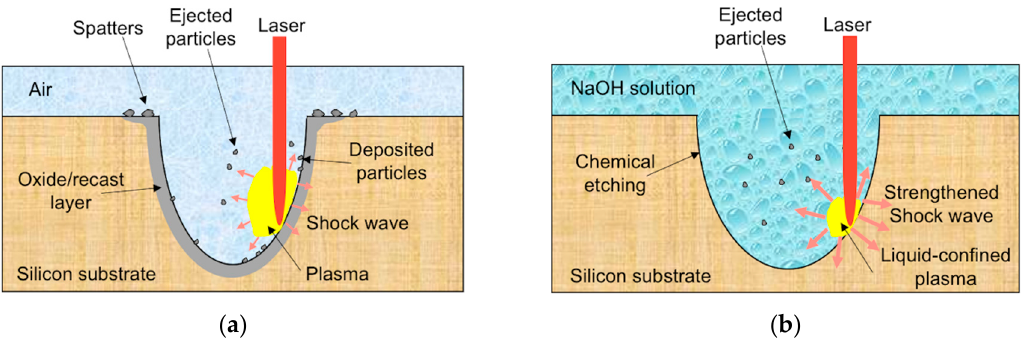
Figure 14. Schematic of material removal mechanism in ( a ) direct laser trepanning and ( b ) the chemical-assisted laser trepanning process.